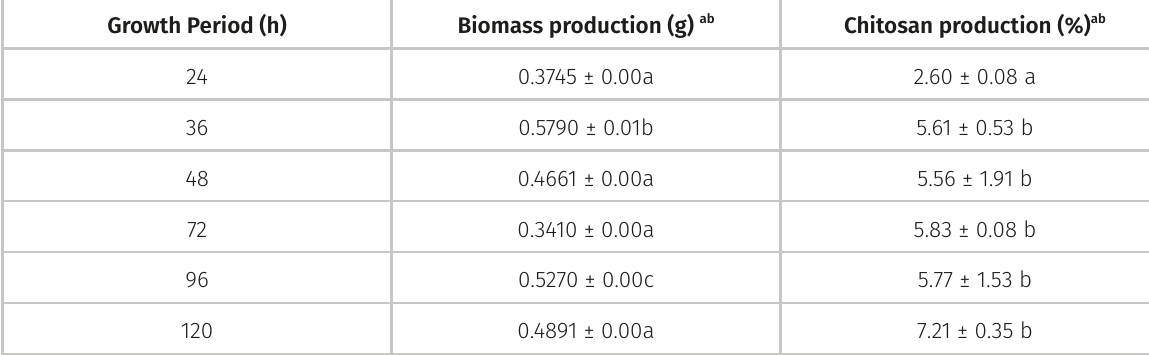
Table IV. Growth curve for dry biomass of Syncephalastrum racemosum and chitosan production in selected condition by factorial